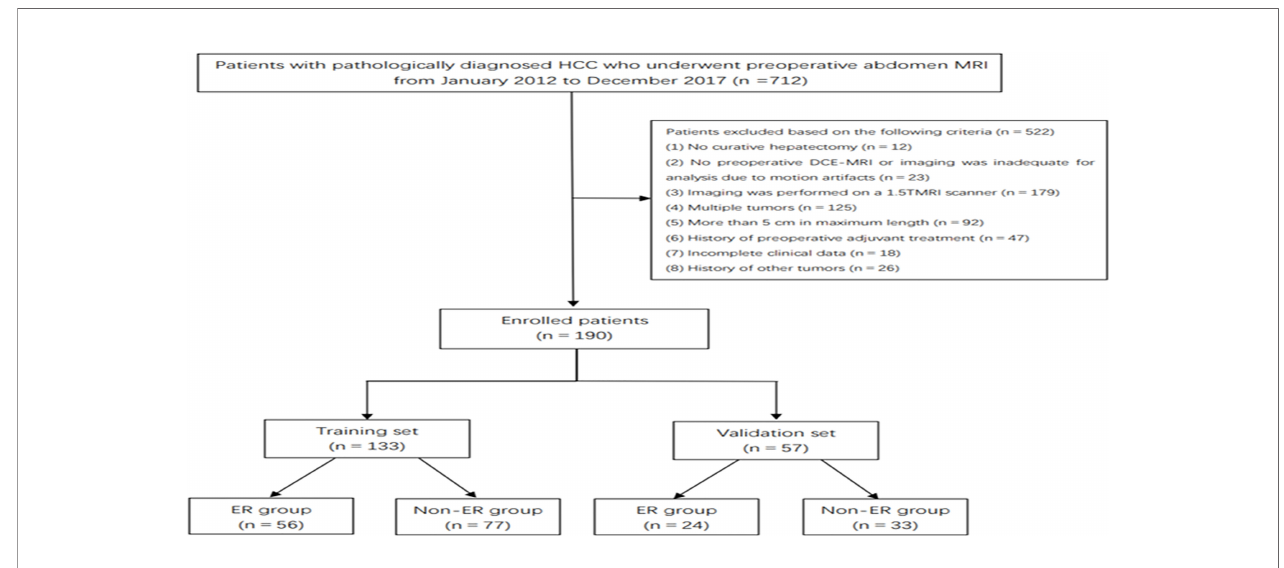
FIGURE 1 | A fl owchart of the study